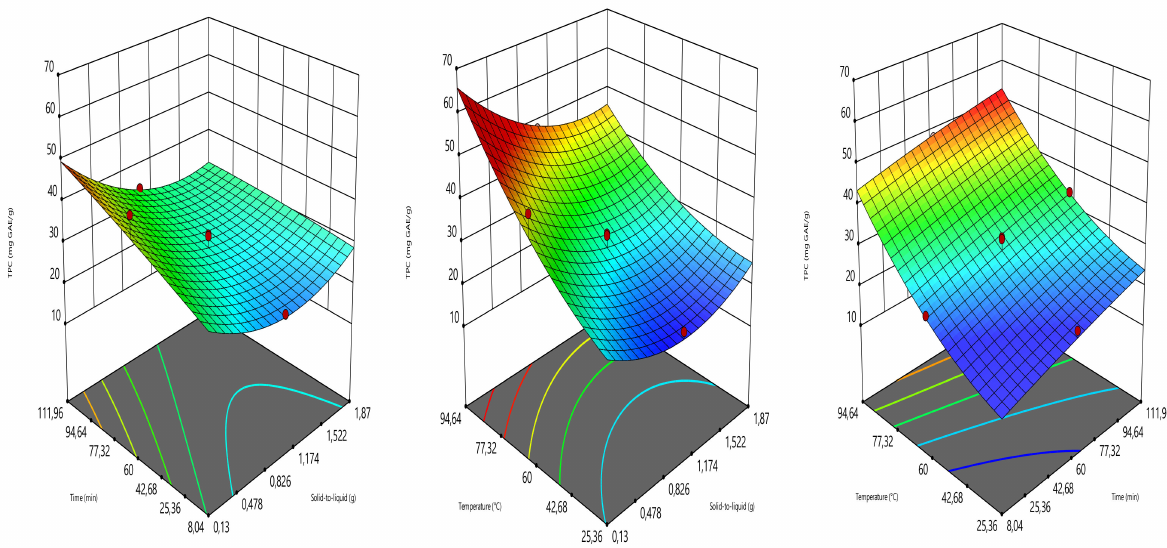
Figure 2. Three-dimensional graphics showing the effects of the independent variables on TPC. For the TFC, the different combinations of the independent variables responded diversely (Figure 3). In the combination of decoction time and solid-to-liquid ratio, the decoction time did not show a significant effect on TFC, while the solid-to-liquid ratio had a significant effect on this response. The TFC showed the highest values at 0.13–1.17 g and then decreased. In the combination of temperature and solid-to-liquid ratio, the solid- to-liquid ratio was almost indifferent while the temperature-induced a strong increase in TFC when augmenting. Whereas the increase in the combination of temperature and time exhibited a great increase in TFC.